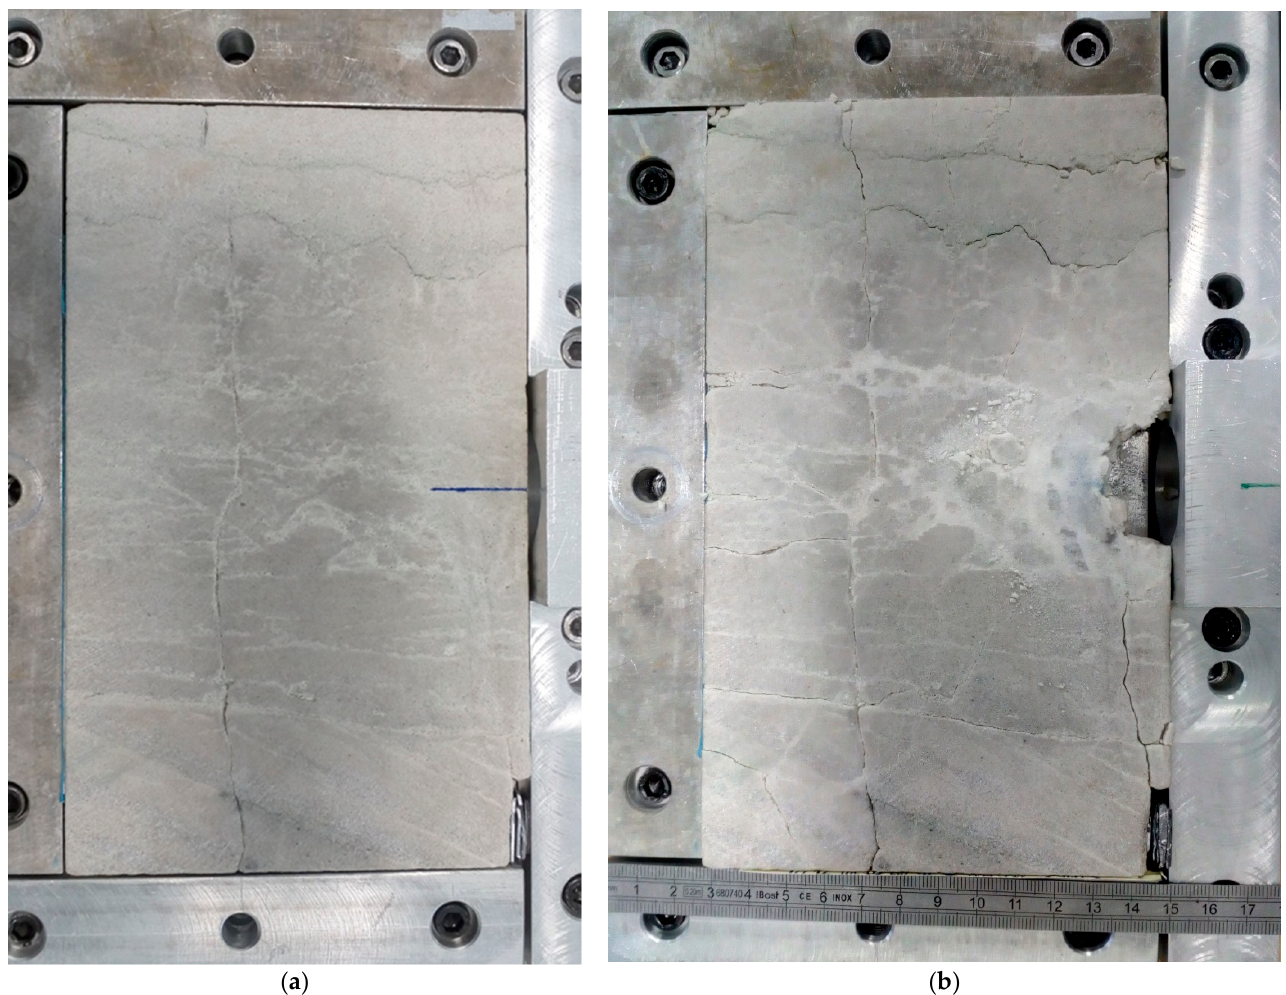
Figure 10. EOI test in the sarcophagus configuration ( v = 162 m/s). Pictures of the target: ( a ) prior to impact and ( b ) after impact.